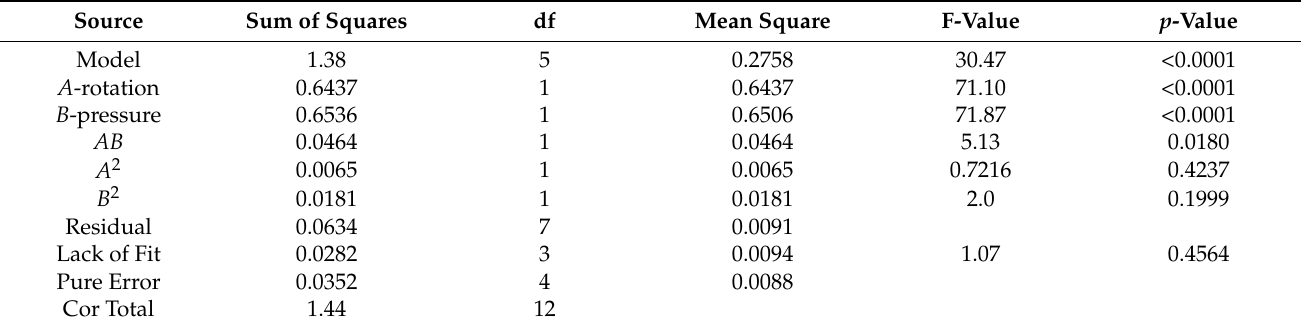
Table 4. Variance analysis of hole number qualified rate.